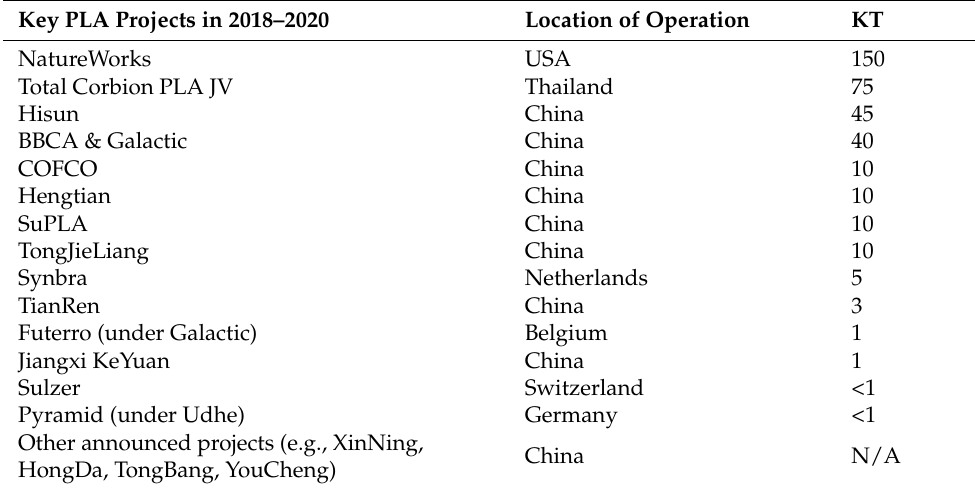
Table 5. Key PLA Projects with estimated capacities in 2019–2020